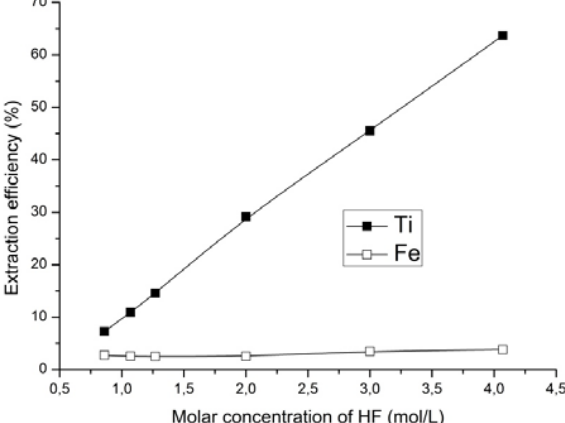
Figure 7. Extraction Ti and Fe vs. HF concentration for a fixed ammonium fluoride concentration of 0.42 mol/L.